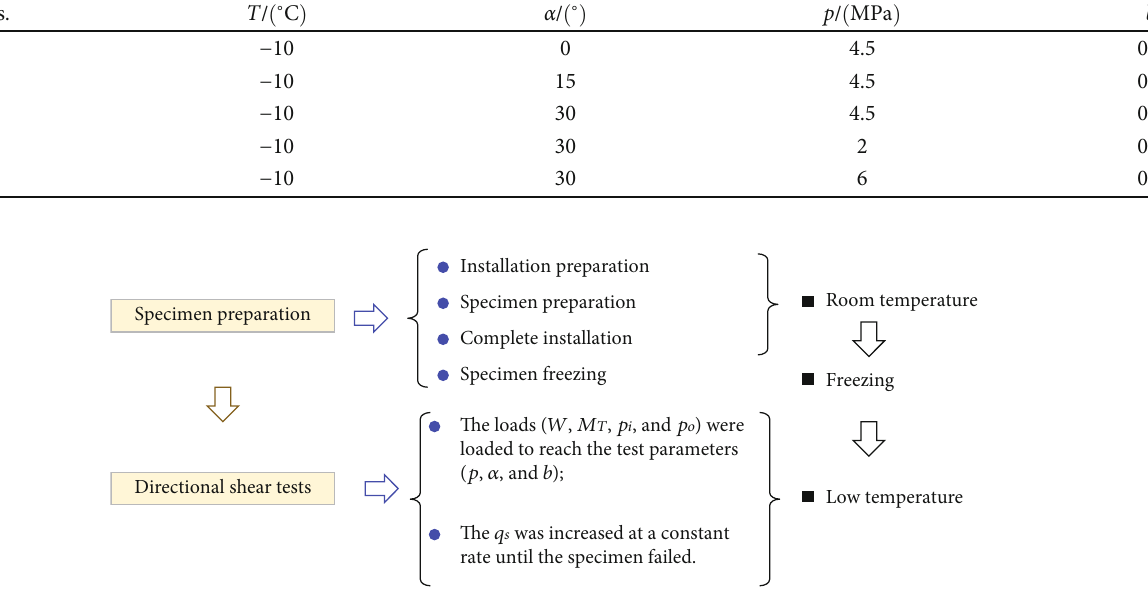
Figure 3: Flowchart of testing program.